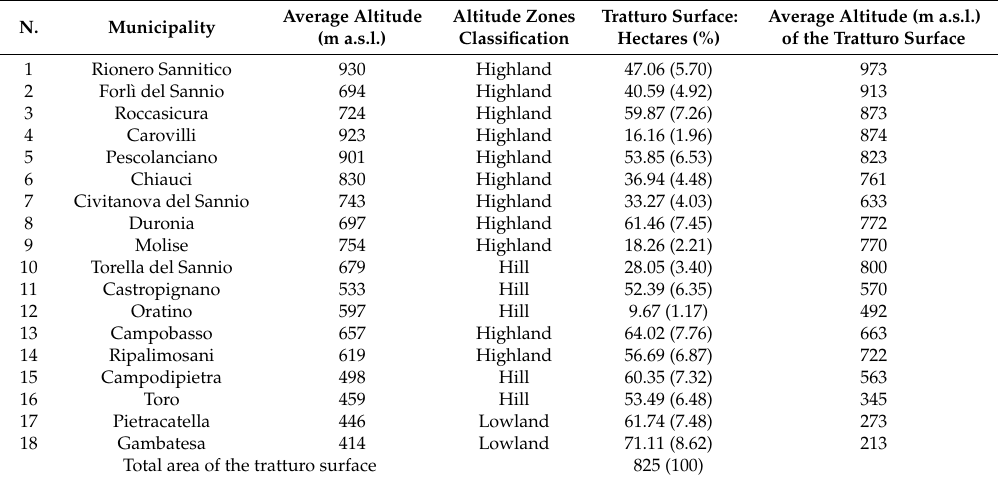
Table 1. Brief description of the 18 municipalities crossed by the Tratturo Castel di Sangro-Lucera (listed from north to south).